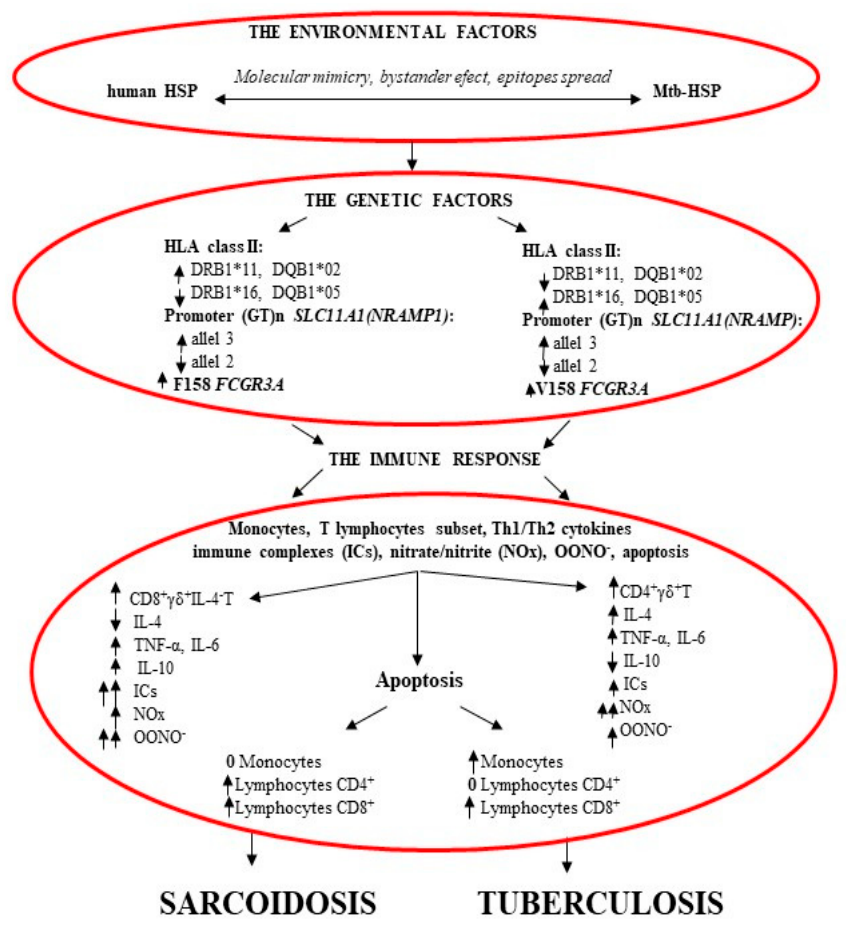
Figure 3. Different roles of mycobacterial Heat Shock Proteins in the pathogenesis of sarcoidosis and tuberculosis.